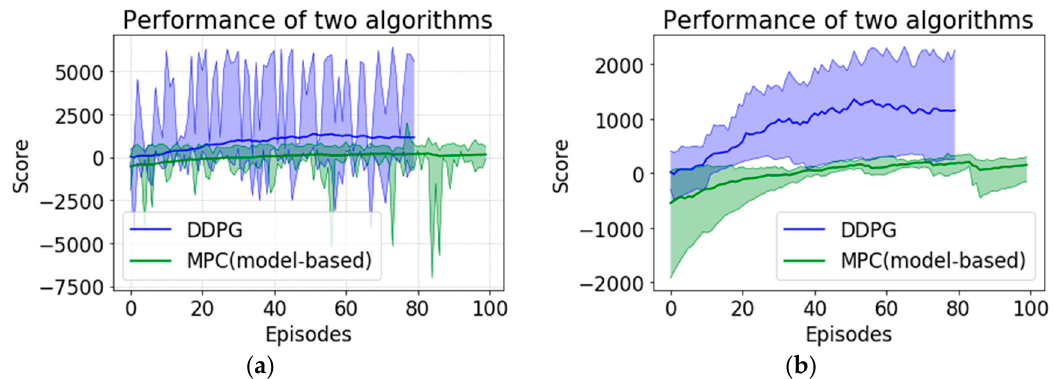
Figure 13. Learning curves for the performance of the policies trained with different methods: ( a ) maximum-to-minimum interval of each episode in five experimental runs and the average performance and ( b ) maximum-to-minimum interval of the average score of each episode in five experimental runs and the average performance.